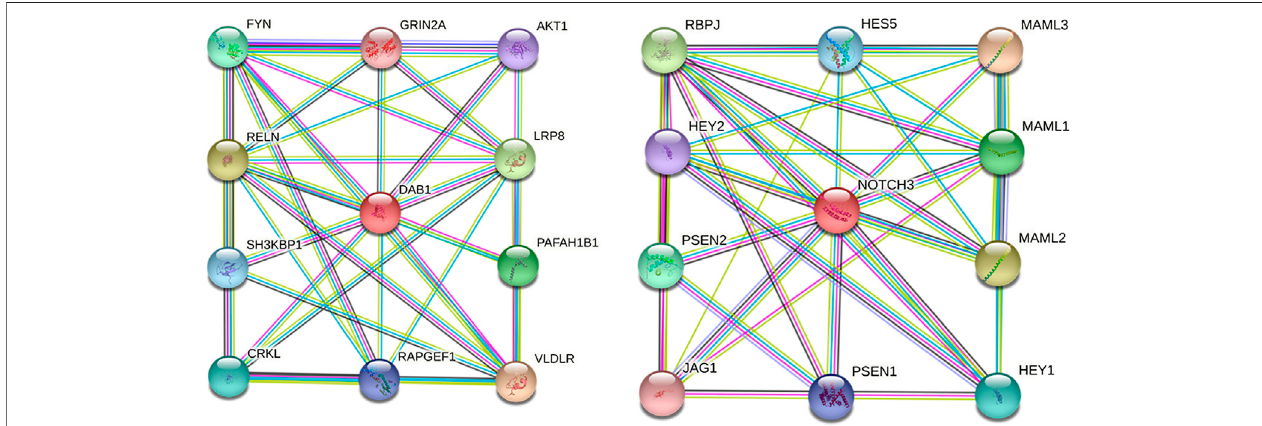
FIGURE7| Protein – protein interaction networkofDAB1and NOTCH3. Predictedfunctionalpartnersareasfollows: VLDLR,verylow-densitylipoproteinreceptor, bindsVLDLand transportsitintocellsbyendocytosis;RELN,Reelin, extracellularmatrixserineproteasethatplaysaroleinlayeringofneuronsinthecerebralcortexand cerebellum; LRP8, low-density lipoprotein receptor-related protein 8; PAFAH1B1, Platelet-activating factor acetylhydrolase IB subunit alpha; FYN, tyrosine-protein kinaseFyn,non-receptortyrosine-proteinkinasethatplaysaroleinmanybiologicalprocesses;CRKL,Crk-likeprotein;SH3KBP1,SH3domain-containingkinase- binding protein 1, adapter protein involved in regulating diverse signal transduction pathways; RAPGEF1, Rap guanine nucleotide exchange factor 1, guanine nucleotide-releasing protein; AKT1, RAC-alpha serine/threonine-protein kinase; GRIN2A, Glutamate receptor ionotropic, NMDA 2A, component of NMDA receptor complexes; MAML3, Mastermind-like protein 3, acts as a transcriptional coactivator for NOTCH proteins; MAML2, Mastermind-like protein 2, acts as a transcriptional coactivator for NOTCH proteins; RBPJ, recombining binding protein suppressor of hairless; MAML1, Mastermind-like protein 1, acts as a transcriptional coactivator for NOTCH proteins; PSEN2, Presenilin-2, probable catalytic subunit of the gamma-secretase complex; HEY1, hairy/enhancer-of-split related with YRPW motif protein 1; HESS, transcription factor HES-5; PSEN1, Presenilin-1, catalytic subunit of the gamma-secretase complex; HEY2, hairy/enhancer-of-split related with YRPW motif protein 2; JAG1, Protein jagged-1, ligand for multiple Notch receptors and involved in the mediation of Notch signaling.